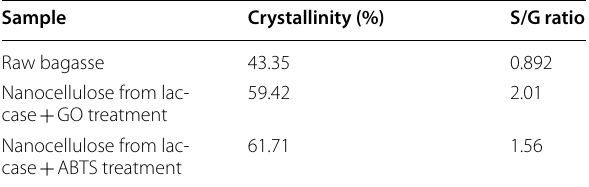
Table 2 Crystallinity percentage of cellulose from XRD analysis and S/G ratio of lignin from FT-IR analysis Sample Crystallinity (%) S/G ratio Raw bagasse 43.35 0.892 Nanocellulose from lac- case